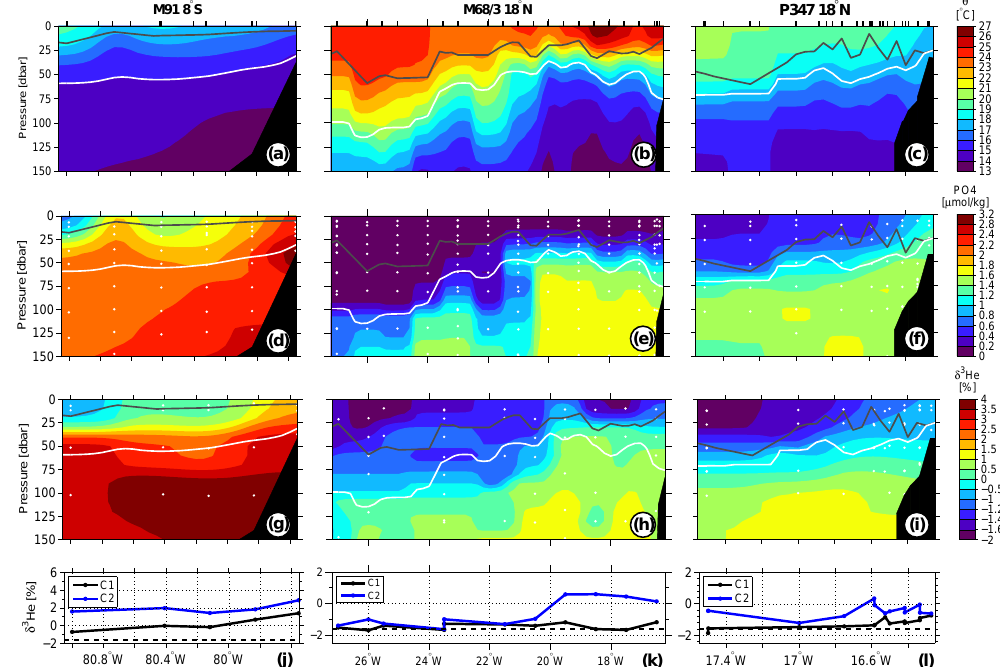
Figure 2. Sections of potential temperature (a–c) , phosphate (d–f) , helium 3 (g – i) for one section from cruise M91 off Peru (along 8 ◦ S), M68/3 (along 18 ◦ N) and P347 (also along 18 ◦ N). The grey line denotes the base of the mixed layer and the white line the